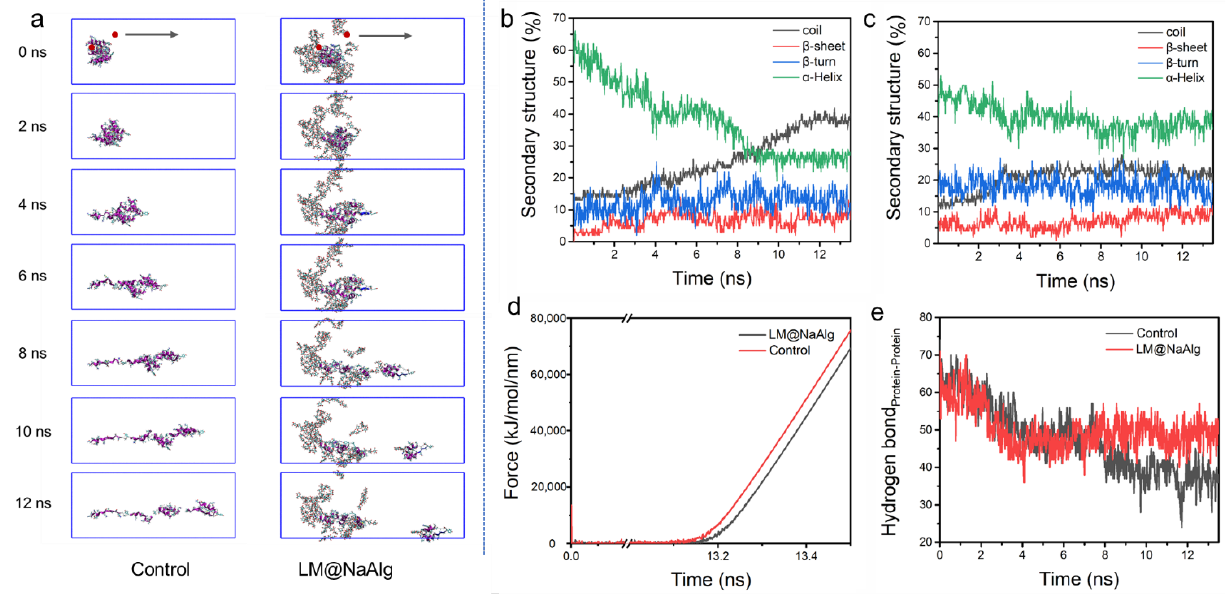
Figure 5. Steered dynamics simulation of the silk. ( a ) The pull process of the silk protein without and with LM@NaAlg-2. The secondary structure of silk protein in the pulling process without ( b ) or with ( c ) LM@NaAlg-2. ( d ) Shear stress associated with the secondary structure transition. ( e ) Hydrogen bond number between silk protein and LM@NaAlg-2 during the steered dynamics process.